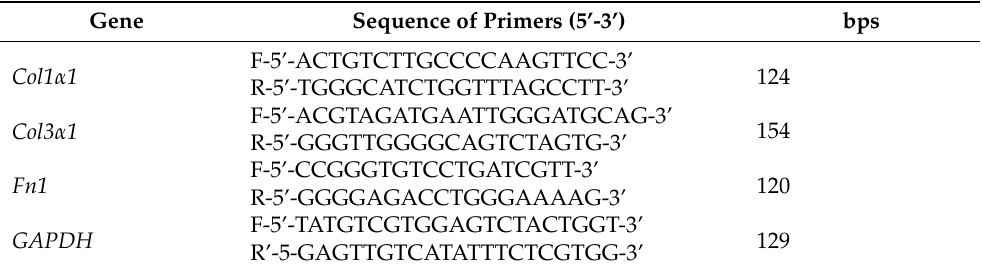
Table 1. qPCR primer sequence and product